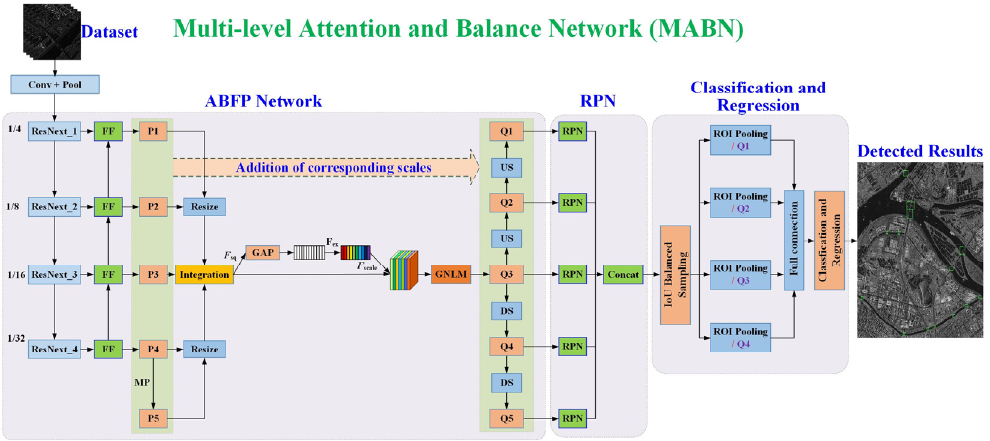
Figure 2. The proposed framework of bridge detection. (‘US’ denotes Up-Sampling and ‘DS’ represents Down-sampling).